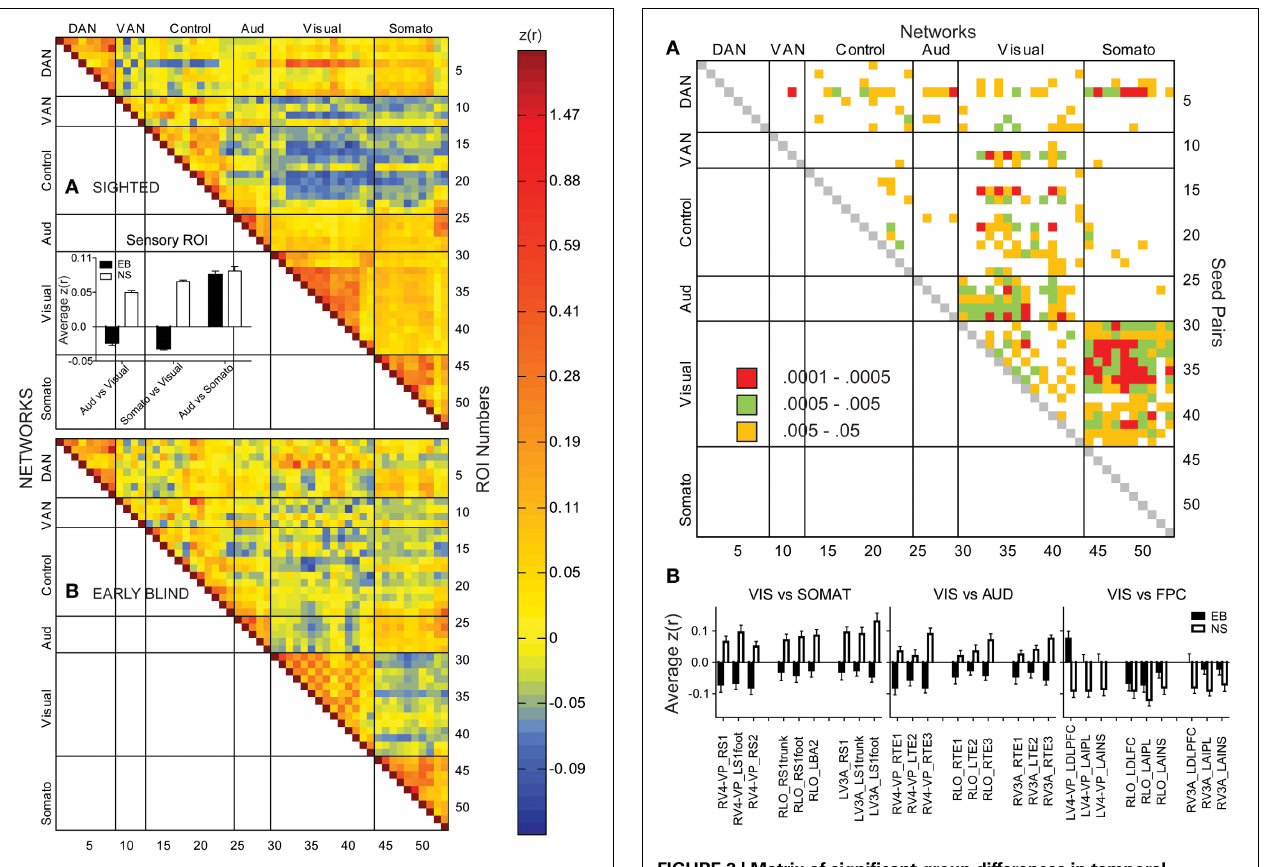
FIGURE 1 | Temporal correlation coefficient matrices computed from spontaneous, resting-state activity recorded for > 16min timelines from 53 paired seed regions in sighted (A) and early blind (B) participants. See Table 2 for identification of ROI Numbers. Seed regions were from different networks: dorsal attention, DAN; ventral attention, VAN; cognitive control, Control; auditory system, Aud; visual system, Visual; somatosensory, Somato. Color coded scale for Pearson correlation coefficients [ Z ( r ) values]. Insert histogram of mean and standard error of Z ( r ) values in each early blind (EB) and normally sighted (NS) across all seed pairings for sensory regions.